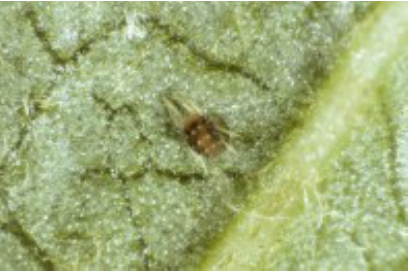
Figure 10. The European fruit tree red spider mite, Panonychus ulmi (Photo: Andrew G. S. Cuthbertson © ).